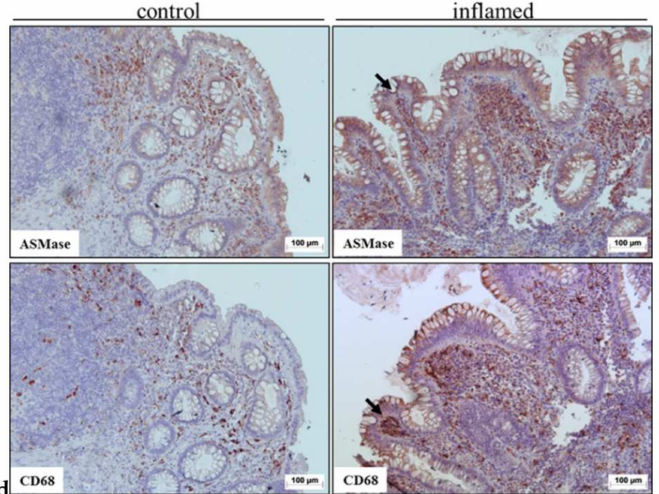
Figure 3. Immunohistochemical staining of aSMase (left upper panel) and macrophages (CD68) (right upper panel) in colons of mice suffering from dextran sodium sulfate (DSS)-induced acute colitis (upper row) ( a ). Mice were sacrificed after receiving 4% DSS for five days in their drinking water to induce acute colitis. The control animals had plain water (lower raw), mice were sacrificed, and colons were collected for immunohistochemical aSMase staining. Representative images of the same crypt fold of the proximal colon are shown. Arrows indicate possible co-localization. Scale bar = 25 µ m. The lower row presents representative proximal colon from healthy control animals stained with aSMase (left) and CD68 (right).The aSMase expression was quantified from the histological slides ( b ). Quantification was done by measuring the area in crypt folds positive for aSMase staining and referring the resulting values to the total crypt fold area in the proximal colon ( b ) and distal colon ( c ). Bars represent mean ± SEM. ( n = 3 per condition). Sphingomyelinase appearance was also analyzed from a human patient sample ( d ). Immunohistochemical staining of aSMase (upper row) and macrophages (CD68) (lower row) in colon tissue from a patient who has Crohn’s disease. Representative images show areas covering several crypts and crypt folds. Colonic tissue from areas regarded as non-inflamed (left) and inflamed (right) was collected, sliced, and immunohistochemically stained. Scale bar = 100 µ